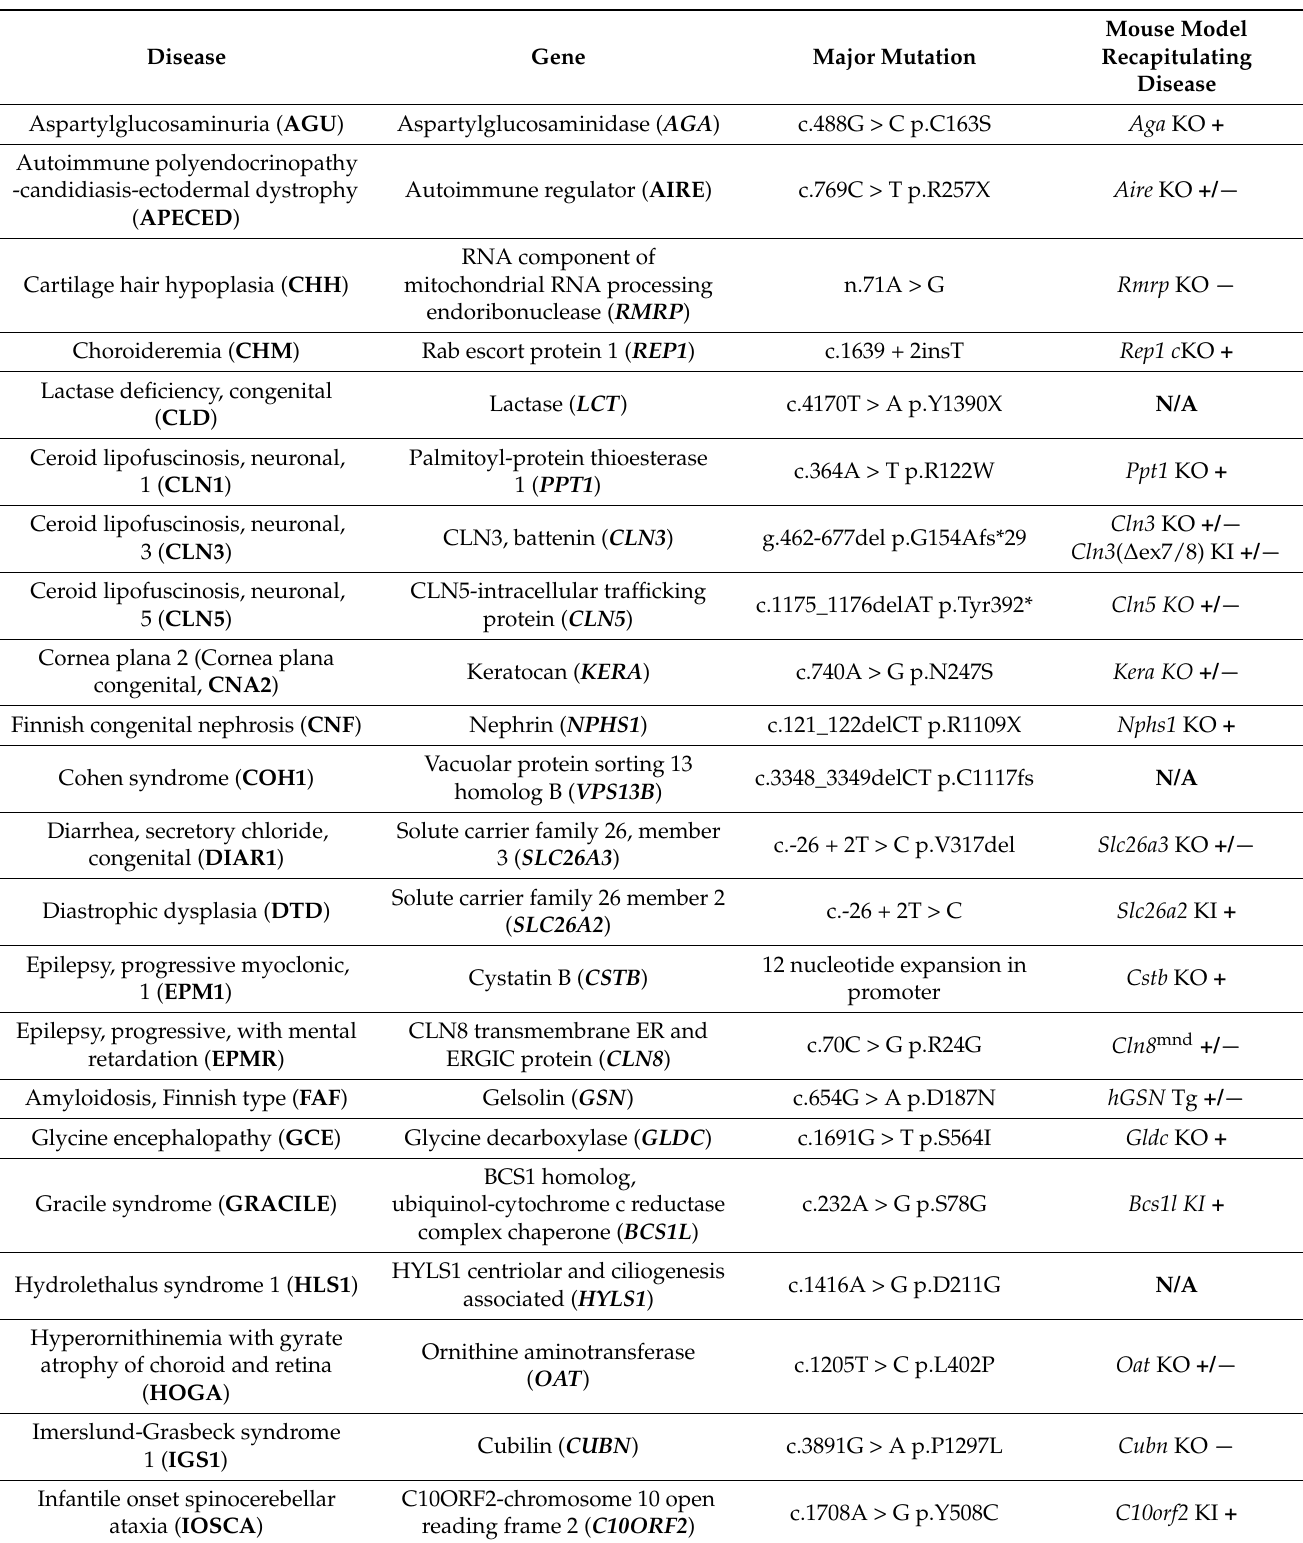
Table 1. Finnish disease heritage diseases and the affected genes with the major Finnish